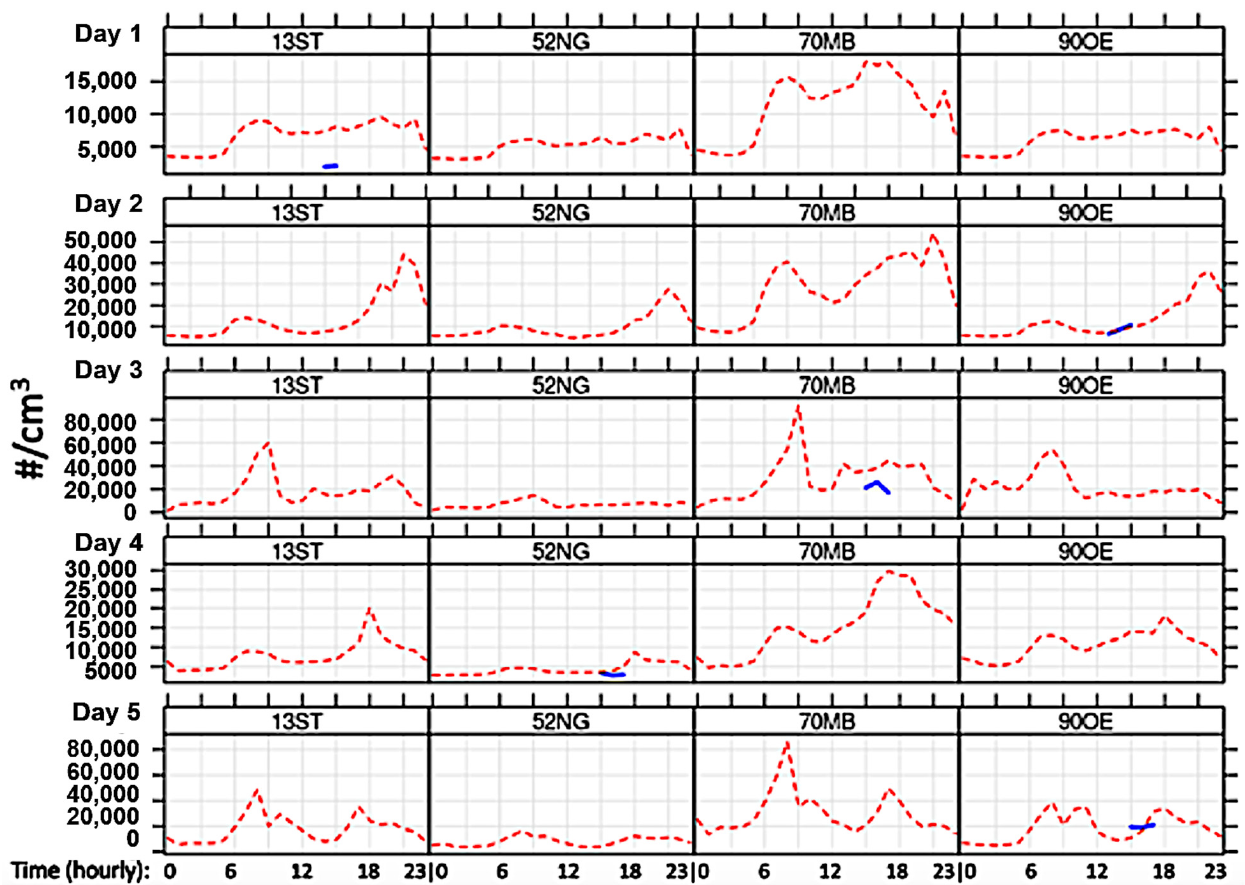
Figure 6. Daily profiles of hourly modeled PN concentrations at the four measurement sites for the five measurement days and the measured PN concentration values at respective daytime. The variation in PN concentrations during the day is mainly controlled by the diurnal variation of emissions and the changes in the meteorological conditions between daytime and nighttime. Red dashed line: model. Blue line segments: measurements. Stations: 13 ST (Sternschanze, urban background); 52 NG (Neugraben; suburban background); 70MB (Max-Brauer Allee, road traffic); 90OE (Övelgönne, close to shore/pier).